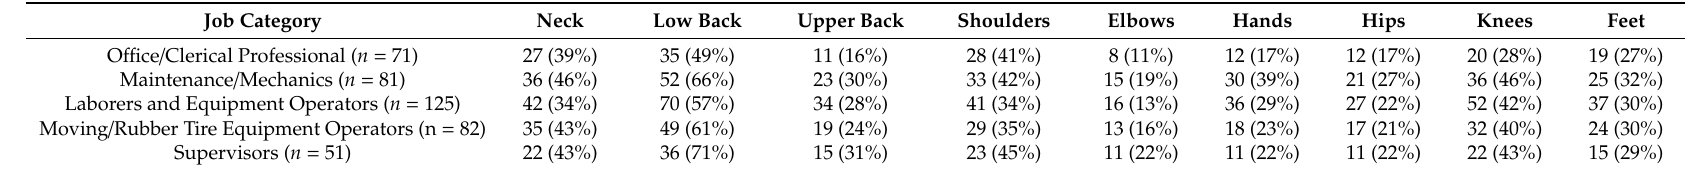
Table 3. Distribution of reported 12-month MSS by job